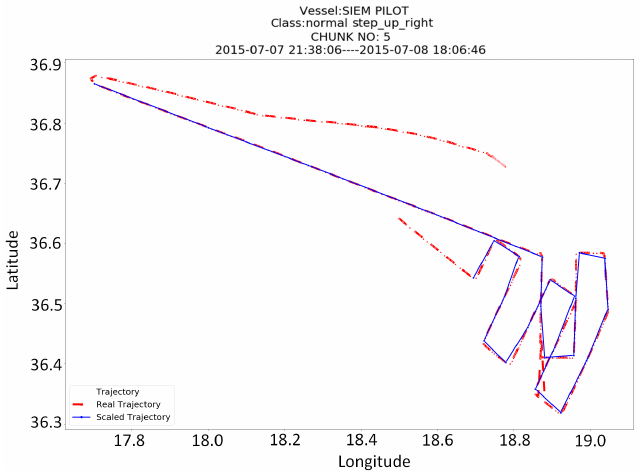
Figure 9. An example of a mis-classification of a creeping line pattern as